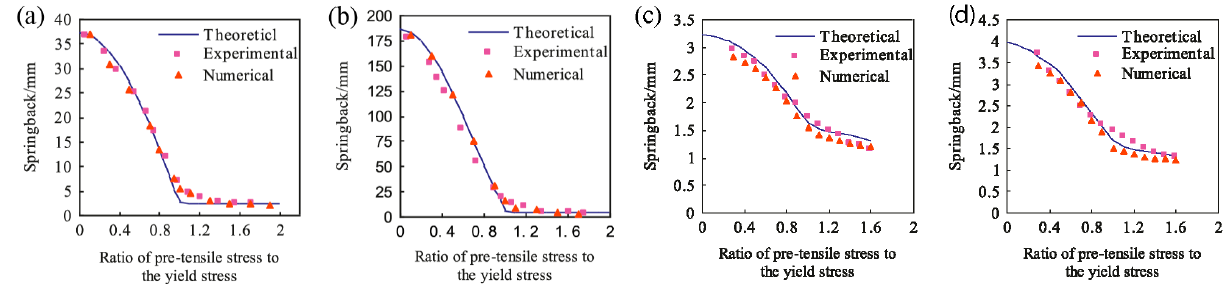
Figure 9. Effect of pretension stress on springback of rectangular section: ( a ) R = 150 mm, ( b ) R = 300 mm, and U-section: ( c ) R = 150 mm, ( d ) R = 200 mm, in the stretch bending process. Reproduced with permission from ref. [46]. Copyright 2013 Elsevier Ltd.